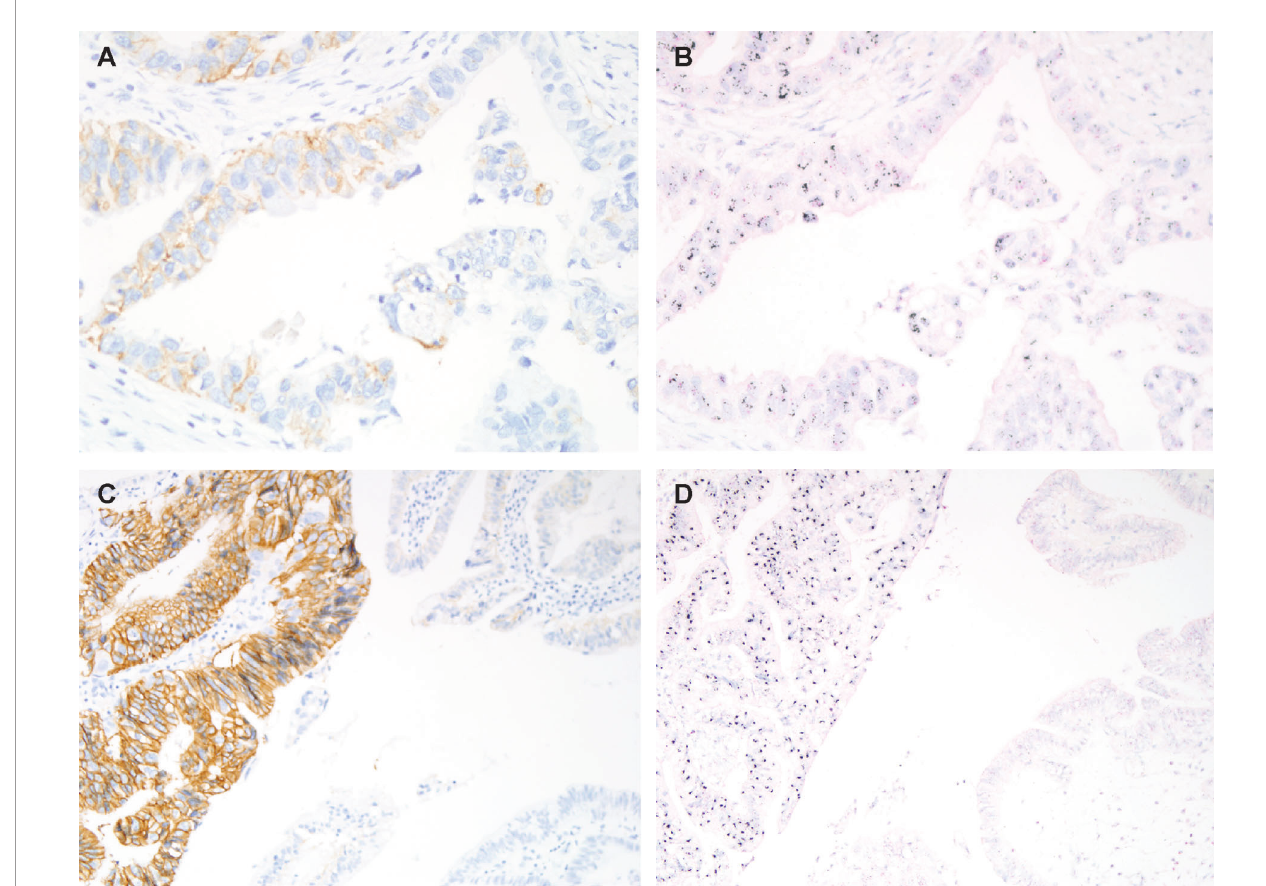
FIGURE 2 | Representative images of matched HER2 immunohistochemical (IHC) staining and HER2 silver in situ hybridization (SISH) from the same case. (A, B) Weak to moderate HER2 IHC staining ( A , left panel, 400×) corresponding to HER2 ampli fi cation as shown by silver in situ hybridization (SISH; B , left panel, 400×). (C, D) Intense HER2 IHC staining at low magni fi cation ( C , left panel, 400×) corresponding to HER2 ampli fi cation as shown by SISH ( D , left panel, 400×). Red dots correspond to CEP17, and black dots correspond to